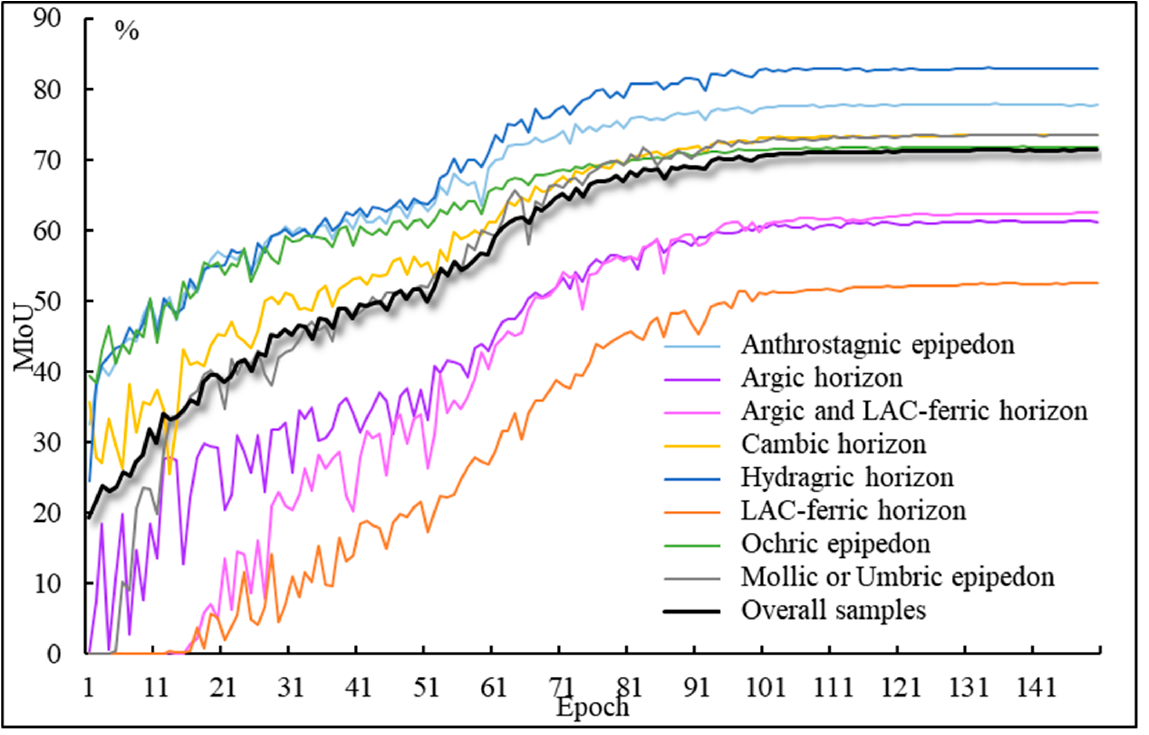
Figure 10. Changes in MIoU with epoch.